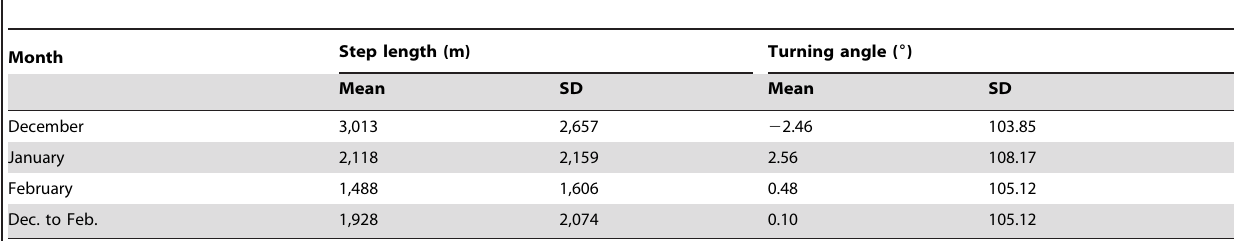
Table 1. Two-day movement parameters for 11 GPS-collared wolves in northeastern Alberta, Canada, 2006–2008. Parameters are based on 2-hour GPS